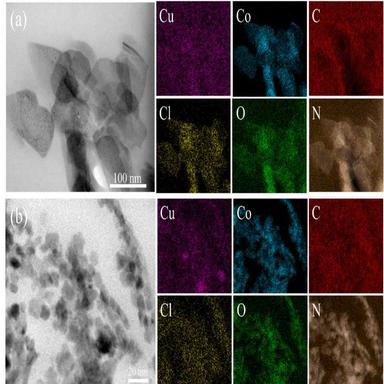
EDS images of (a) Cu-IM/Co-MOF, (b) Cu-IM/Co-MOF 250.